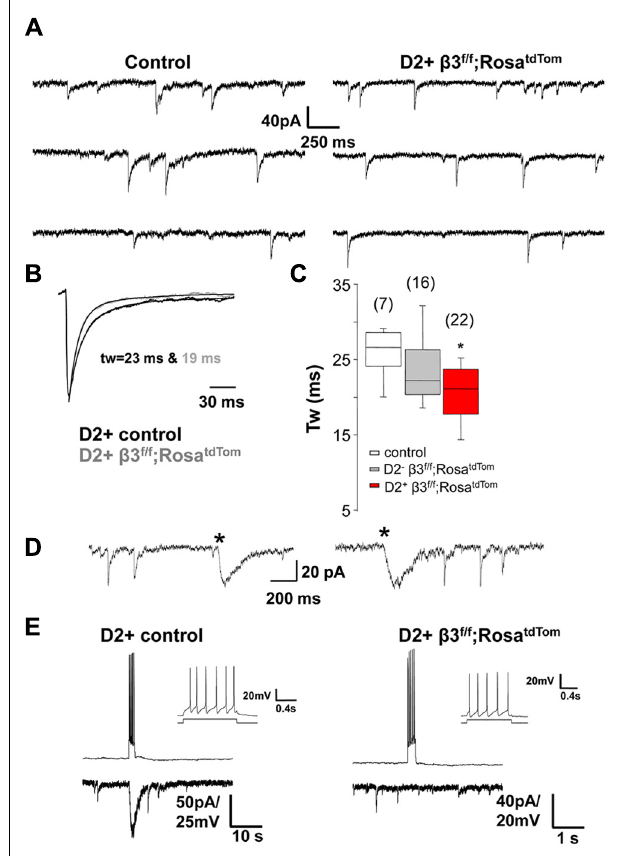
FIGURE 4 | Synaptic decay is altered specifically in β 3 − / − MSNs. (A) Representative raw traces of mIPSCs from a control D2 + MSN and a β 3 f / f ;Rosa tdTom D2 + MSNs. (B) Average normalized mIPSCs with double exponential fitting illustrating difference in T w between the two cells shown in A. (C) Box plot summarizing the weighted decay time constant of average mIPSCs measured in MSNs from the three genotypes as indicated ∗ p < 0.05. One-way ANOVA for repeated measures followed byTukey’s post hoc test. (D) Representative traces of the rarely occurring spontaneous slow IPSCs ( ∗ ) from two MSNs in different control mice. Slow IPSC were identified by the distinctively slow rise and decay kinetics. (E) Burst of action potentials in a presynaptic NGF-NPY neuron elicited a large slow IPSC only in the D2 + control neuron (left) and not in the β 3 − / − D2 + MSNs.The NGF-NPY cells were identified in the β 3 − / − mice by soma size and the characteristic firing pattern